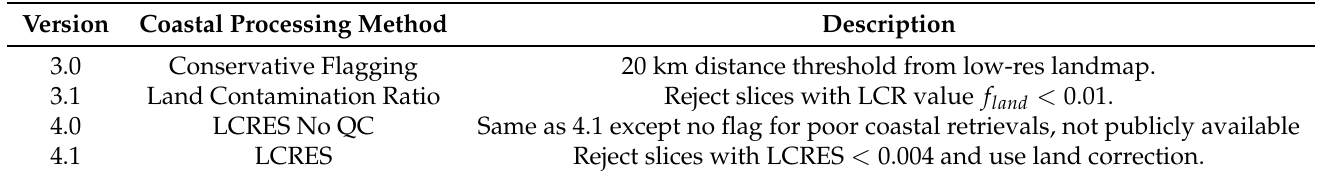
Table 1. QuikSCAT Data Versions.